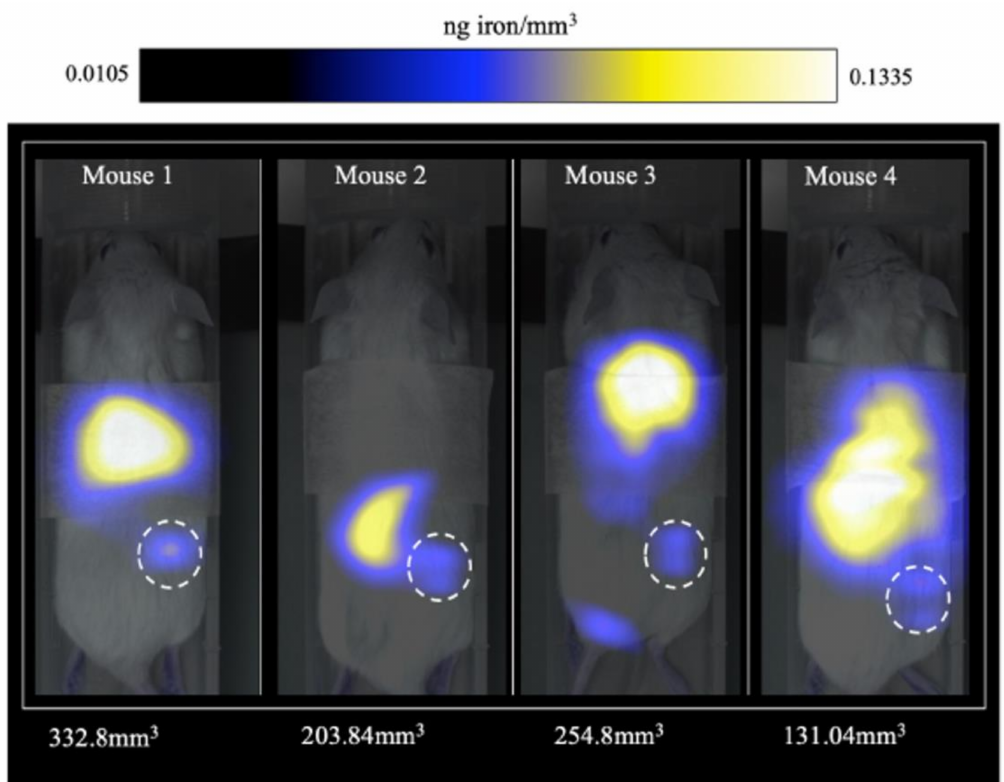
Figure 17. MPI signal representing iron-labeled experimental CTCs detected in the lower right mammary fat pad (MFP) tumors of all mice. Adapted with permission from [148], Copyright 2021 The Royal Society of